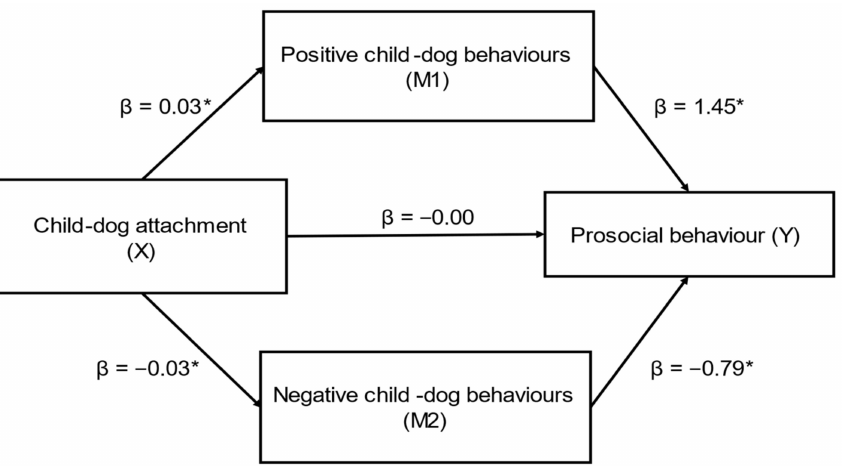
Figure 4. Positive and negative child–dog behaviours as mediators in the relationship between child–dog attachment and prosocial behaviour (SDQ) ( n = 83) (ab cs = 0.38, large effect). Note: * = significant pathway.